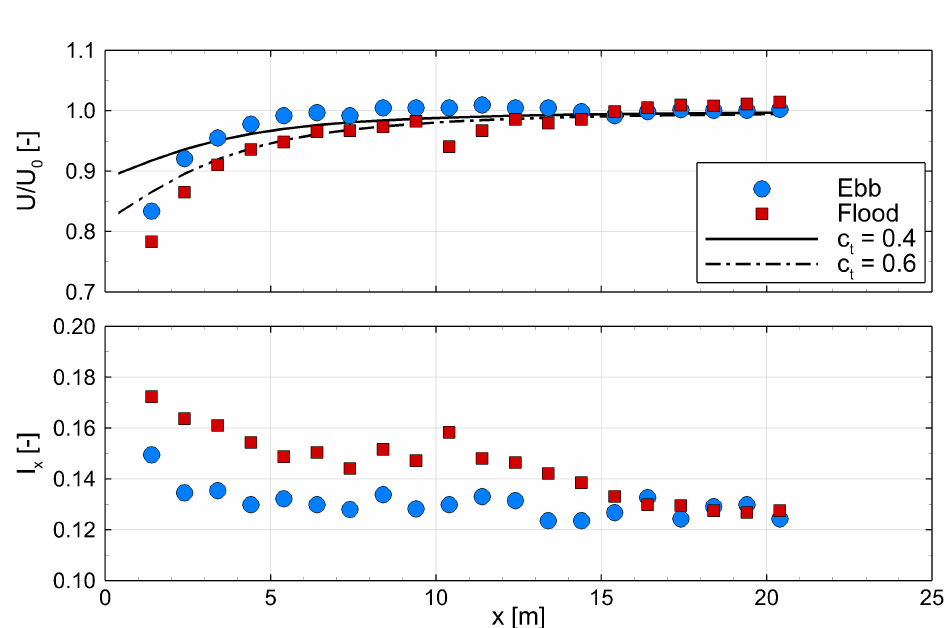
Figure 10. Normalised hub height approach flow velocity ( top ) and turbulence intensity ( bottom ) profiles measured with the turbine ADP during peak ebb and flood tides, i.e., e 2 and f 2. Comparison with vortex sheet theory predictions (Equation (7)) for different c t